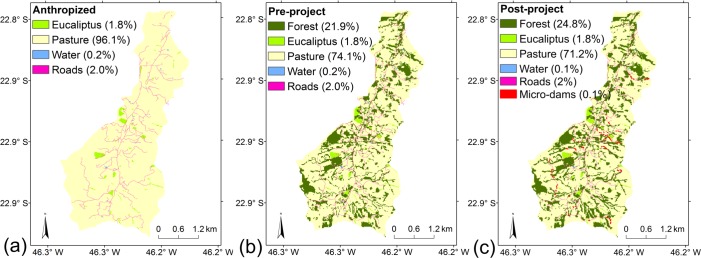
Simulated land use scenarios considered in the current study: (a) Anthropized, with no management and all remnant forest converted into pastureland; (b) Pre-Project, characterizing land-use at the beginning of Conservador das Águas Project in 2005; and (c) Post-Project, the land-use that may be achieved after some years from project start. In (c), the area of the micro-dams was amplified for easy viewing.